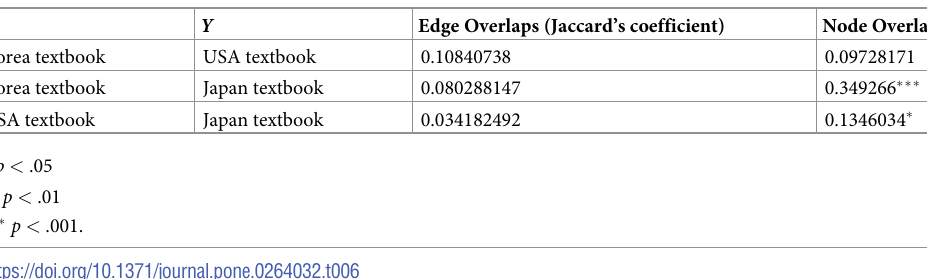
Table 6. Network overlaps (textbook vs.